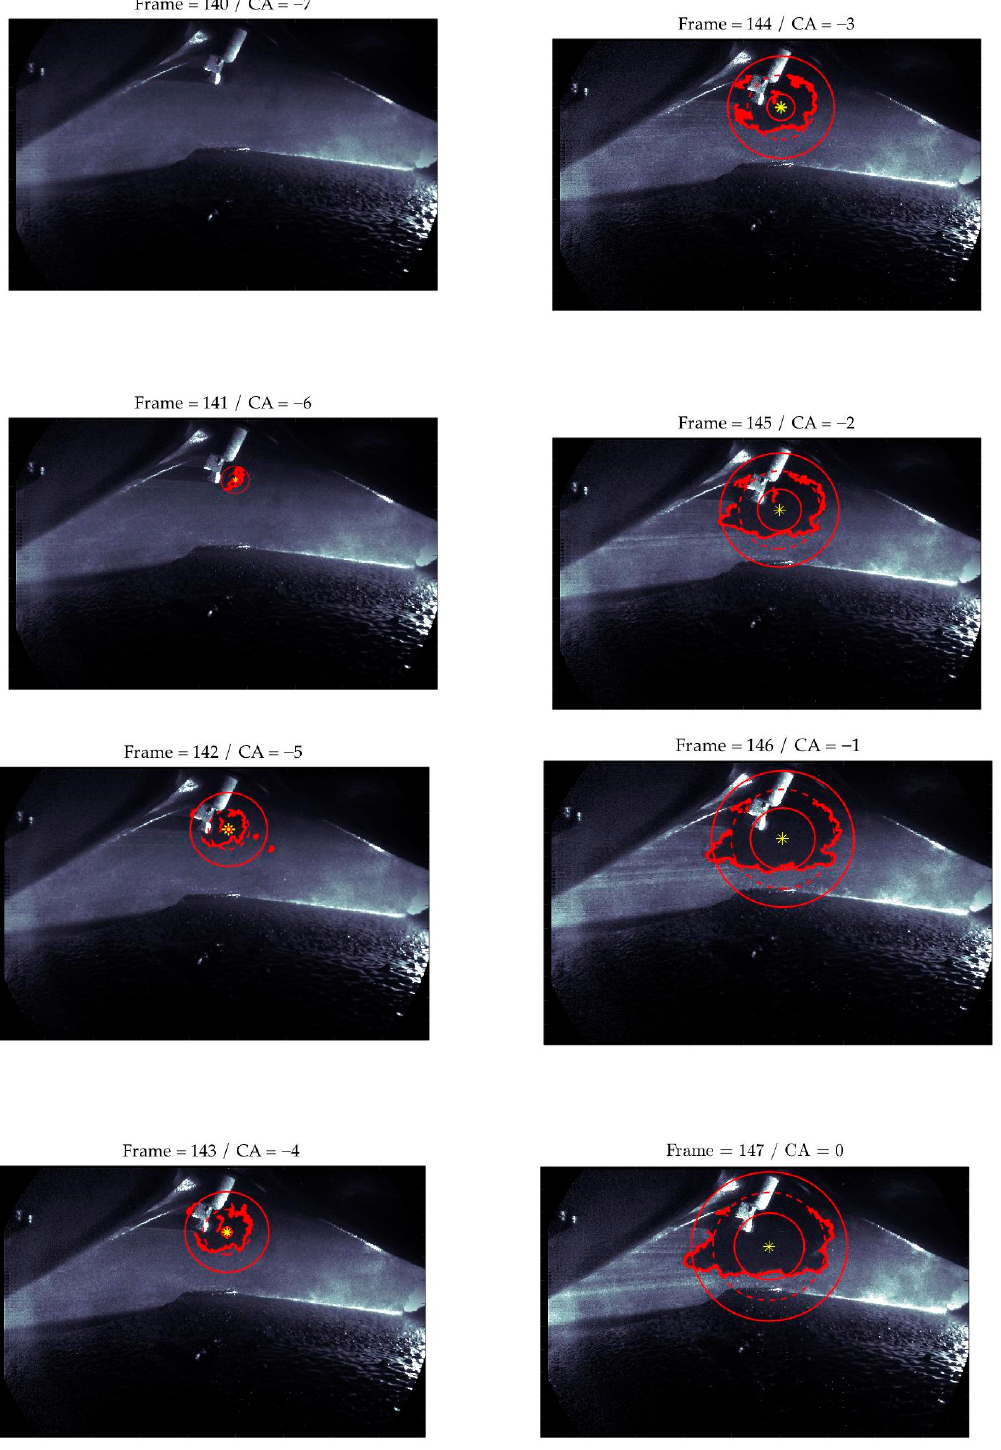
Figure 11. Cycle 58. Background corrected images of turbulent flame from − 7 CAD to TDC firing. Superimposed geometric properties: flame edges, flame center, min, max, and average radii. Engine operation: 1000 RPM, wide open throttle.